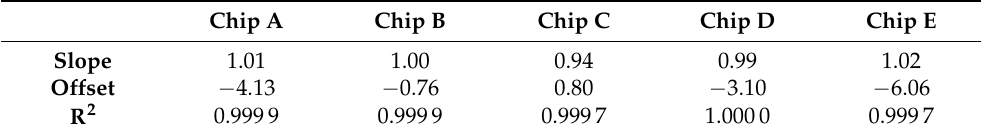
Table 2. Measured linearity, offset and coefficient of determination (R 2 ) of the temperature depen- dence of five Timepix3 detectors on preset temperature by an external device. Chip A Chip B Chip C